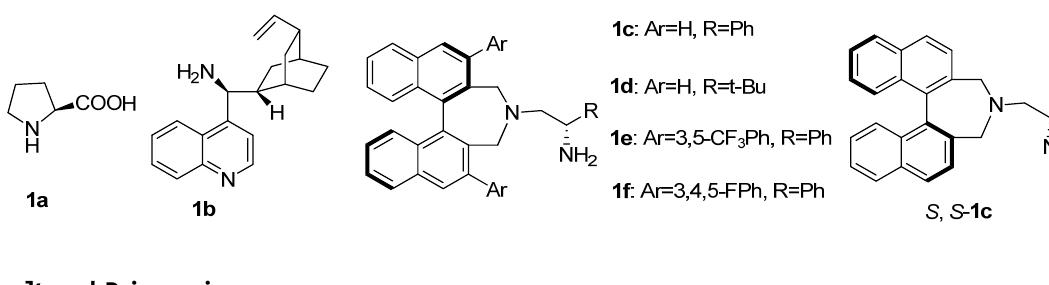
Figure 1. The catalysts surveyed in the